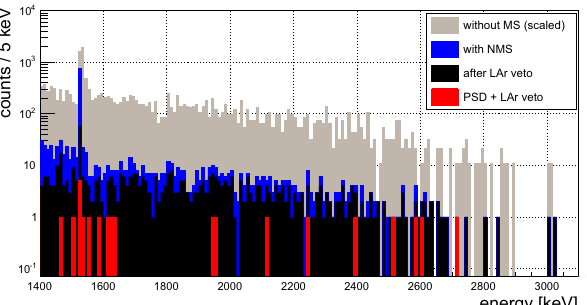
Fig. 8 Suppression of the events from 42 Ar decays by the nylon mini- shroud (NMS), LAr veto and PSD: the grey area shows the scaled spec- trum from a measurement with a bare BEGe detector without NMS, ‘blue’ the measurement with NMS, ‘black’ the events surviving the LAr veto cut, and ‘red’ the remaining events after both the LAr veto and PSD cuts [20]